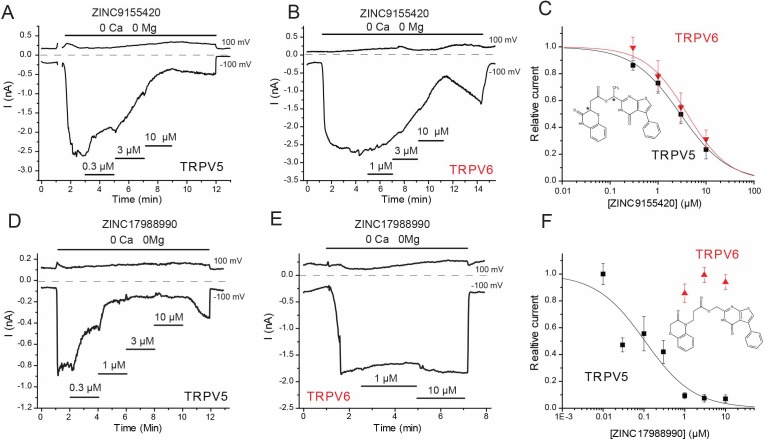
Effects of novel inhibitors on TRPV5 and TRPV6 activity.HEK293 cells were transfected with rabbit TRPV5 or human TRPV6. Whole cell patch clamp experiments were performed as described in the methods section; monovalent currents were initiated using a divalent cation free solution. Currents are shown at 100 and −100 mV; zero currents are indicated by the dashed lines. (A–B) Representative traces for the effects of ZINC9155420 on (A) TRPV5 and (B) TRPV6 currents, the applications of various concentrations of ZINC9155420 are indicated with the horizontal lines. (C) Summary of the data, current levels after two minutes of applying the various concentrations of the compounds were divided by basal current levels before the application of the drug. The data were fitted using the Hill1 equation with the Origin 8.0 software; data are plotted as mean ± SEM (n = 6 for each concentration for TRPV6 and n = 8–11 for each concentration for TRPV5). Inset shows the chemical formula for ZINC9155420. Asterisks denote chiral centers. (D–E) Representative traces for the effects of ZINC17988990 on (D) TRPV5 and (E) TRPV6 currents, the applications of various concentrations of ZINC17988990 are indicated with the horizontal lines. (F) Summary of the data, analyzed and plotted as in panel C (n = 5–15 for each concentration). Inset shows the chemical formula for ZINC17988990.10.7554/eLife.49572.004Figure 1—source data 1.SBVS compound hits.ZINC IDs and 2D chemical structures for the 65 unique chemical scaffolds identified in the in silico compound screen.10.7554/eLife.49572.005Figure 1—source data 2.In silico hits that had no effect on TRPV5 activity.Listed are compounds identified in the SBVS that showed no effect on rbTRPV5 current in our system. The effect of each compound was tested at the listed concentration. N indicates the number of replicates tested.10.7554/eLife.49572.007Figure 1—source data 3.ZINC9155420 derivatives that had no effect on TRPV5 activity.ZINC IDs and 2D chemical structures for the ZINC9155420 derivatives that did not alter TRPV5 activity. The effect of each compound was tested at the listed concentration. N indicates the number of replicates tested.